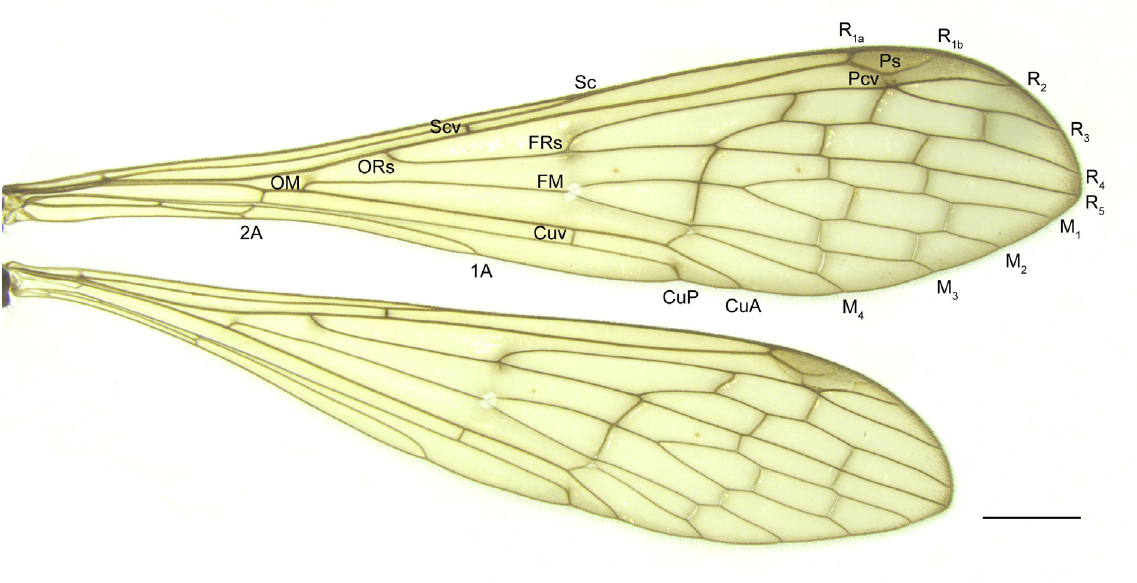
Fig. 9. Right wings of Bittacus multisetus sp. nov., ♀, paratype (NWAU). Abbreviations: see Material and methods. Scale bar = 2.0 mm.